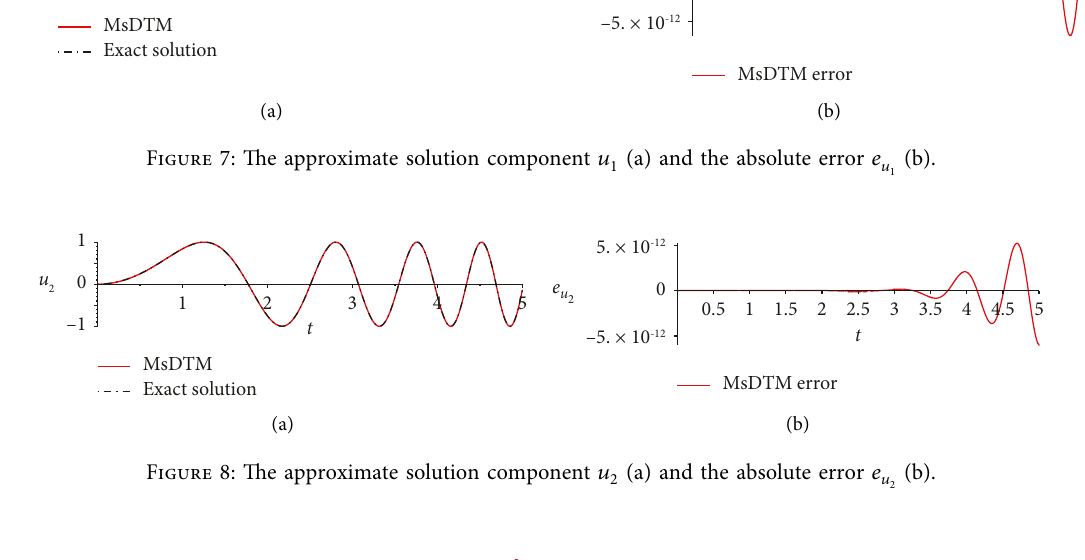
(a) and the absolute error e u 2